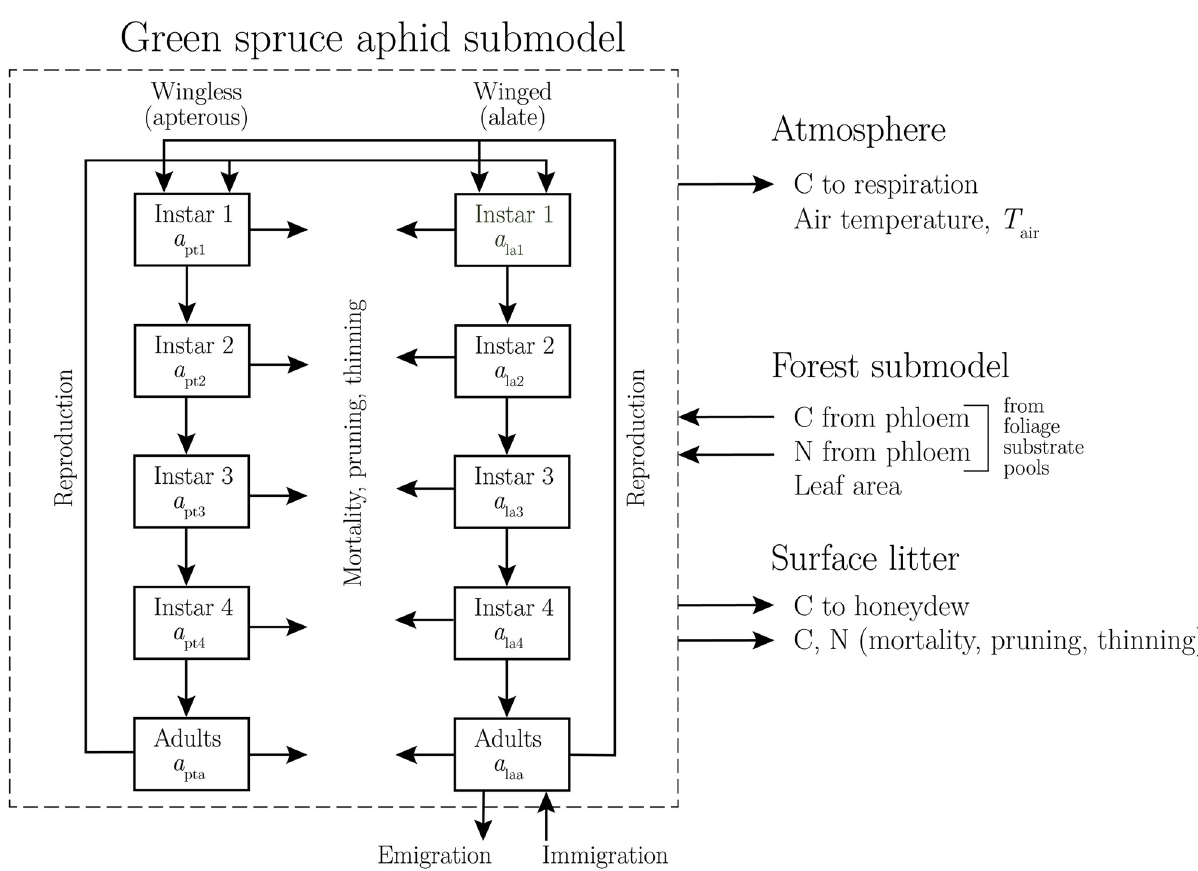
Fig 2. The green spruce aphid sub-model. The ten state variables of the sub-model are shown in the boxes. There are four instars and an adult form for the wingless (apterous) and the winged (alate) aphids. Units for the state variables are number of aphids per stem (Appendix D in S1 Appendix). The differential equations for the state variables are Eqs (16), (47), (64) and